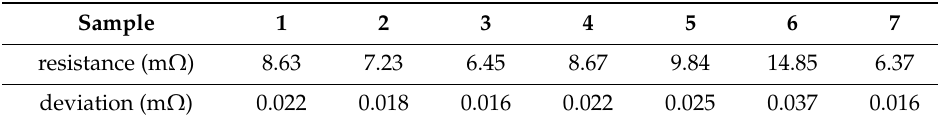
Table 1. Resistance of the samples.